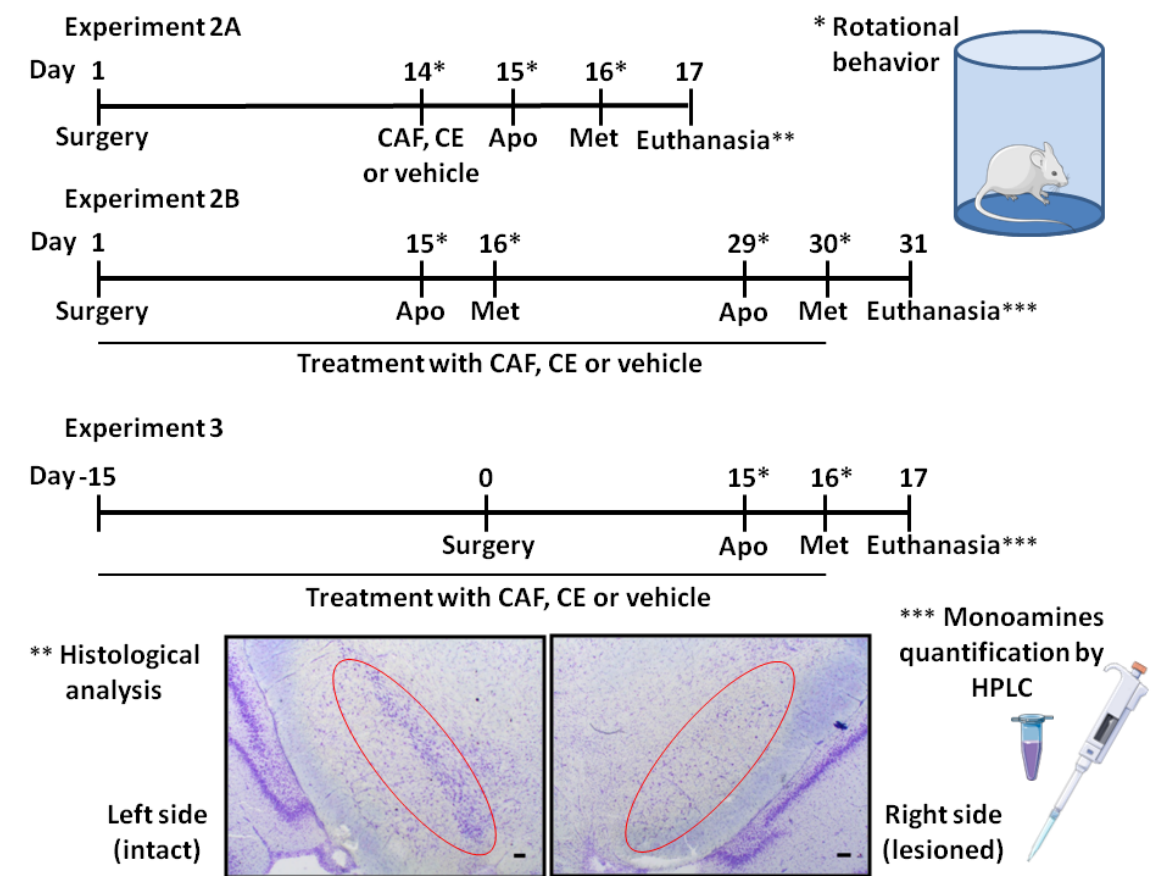
Figure 1. Schematic representation of the experimental design for the 6-OHDA unilateral lesion model. Experiments 2A and 2B: lesion on medial forebrain bundle (MFB); experiment 3: lesion on striatum. The low panel shows a representative photomicrograph of a coronal section submitted to cresyl violet staining. CE = coffee extract, CAF = caffeine, APO = apomorphine, MET =